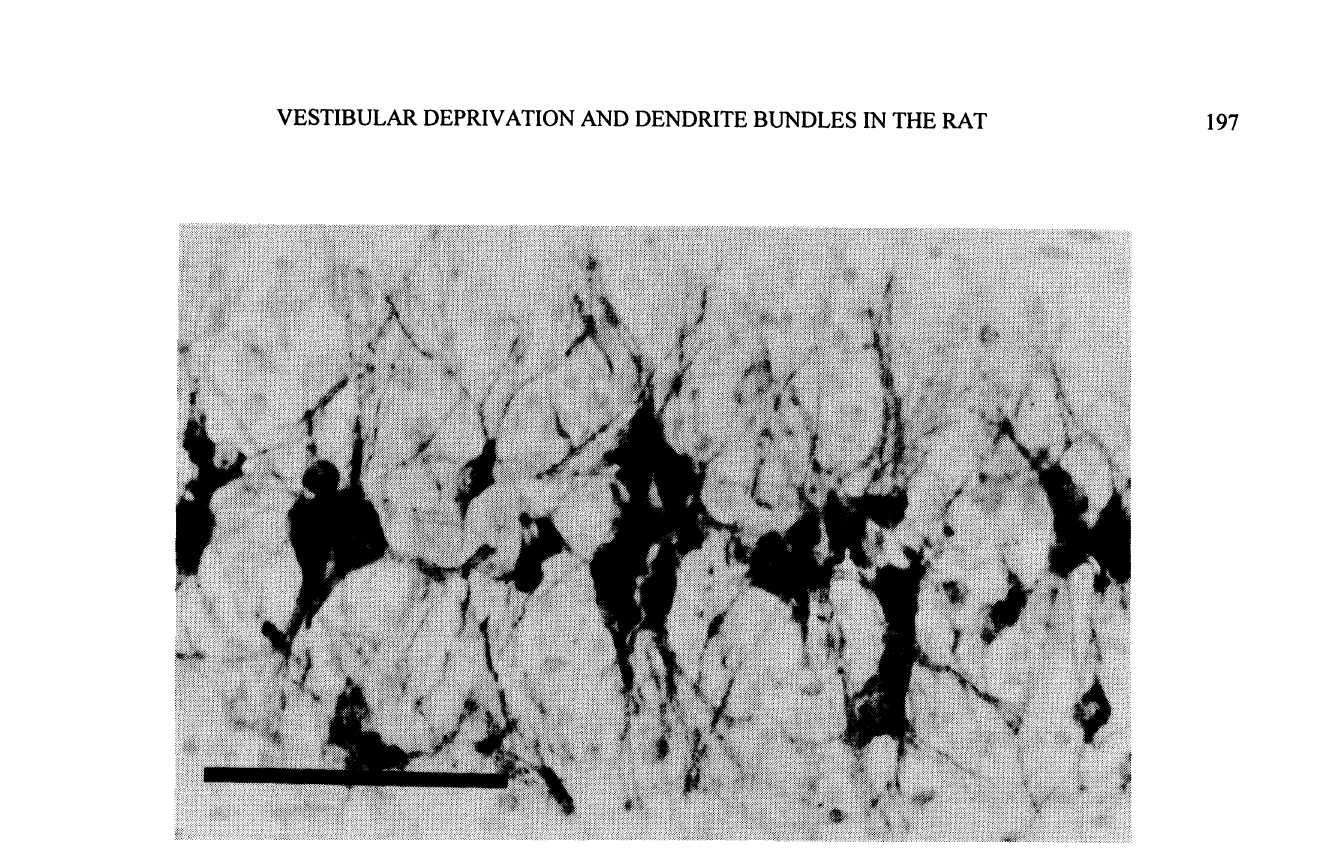
Fig. 1: Motoneuronal pool of the longissimus muscle at P 1. Horizontal section. Most dendrites course in medio-lateral directions. Scaling bar, O0 tm; this bar also indicates the medial side.